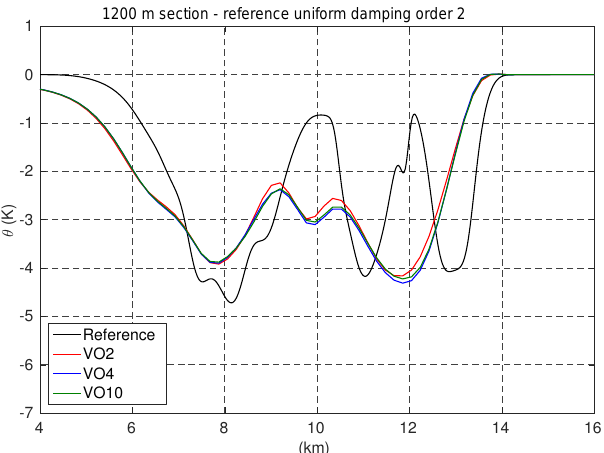
Figure 14. Straka density current test at vertical order 2, 4, and 10. Coarse, evaluation resolution of (cid:49)x = 190m and (cid:49)z = 160m with explicit second-order diffusion with ν 0 = 75m 2 s − 1 compared at 1200m with the reference solution ( (cid:49)x = 25m and (cid:49)z = 25m). Results for Lorenz (LOR) staggering